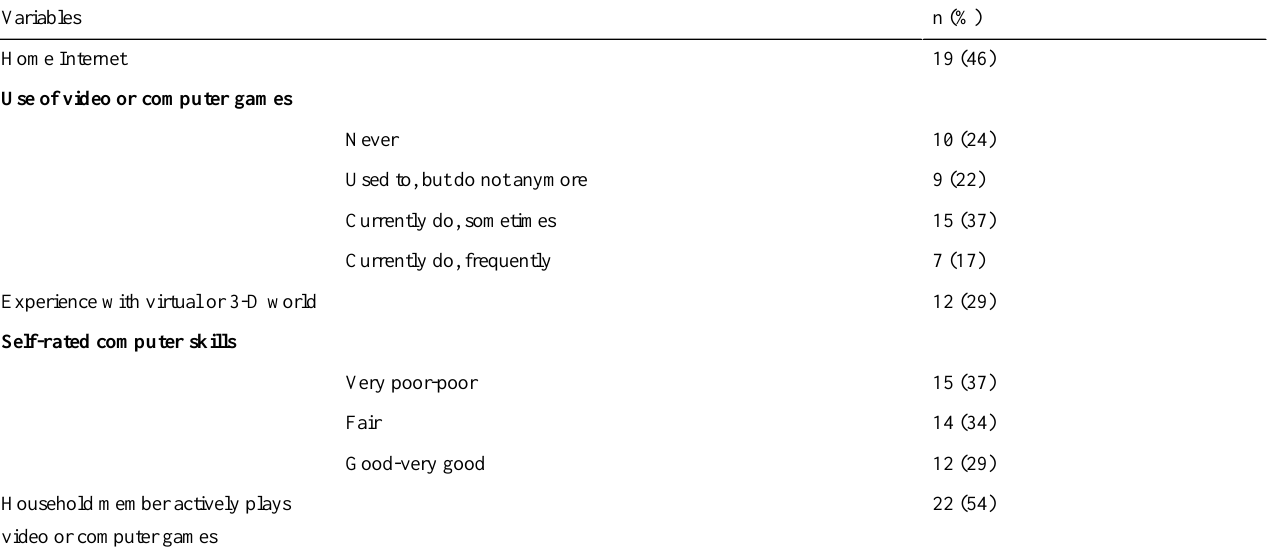
Table 2. Technology characteristics of the study participants (N=41).